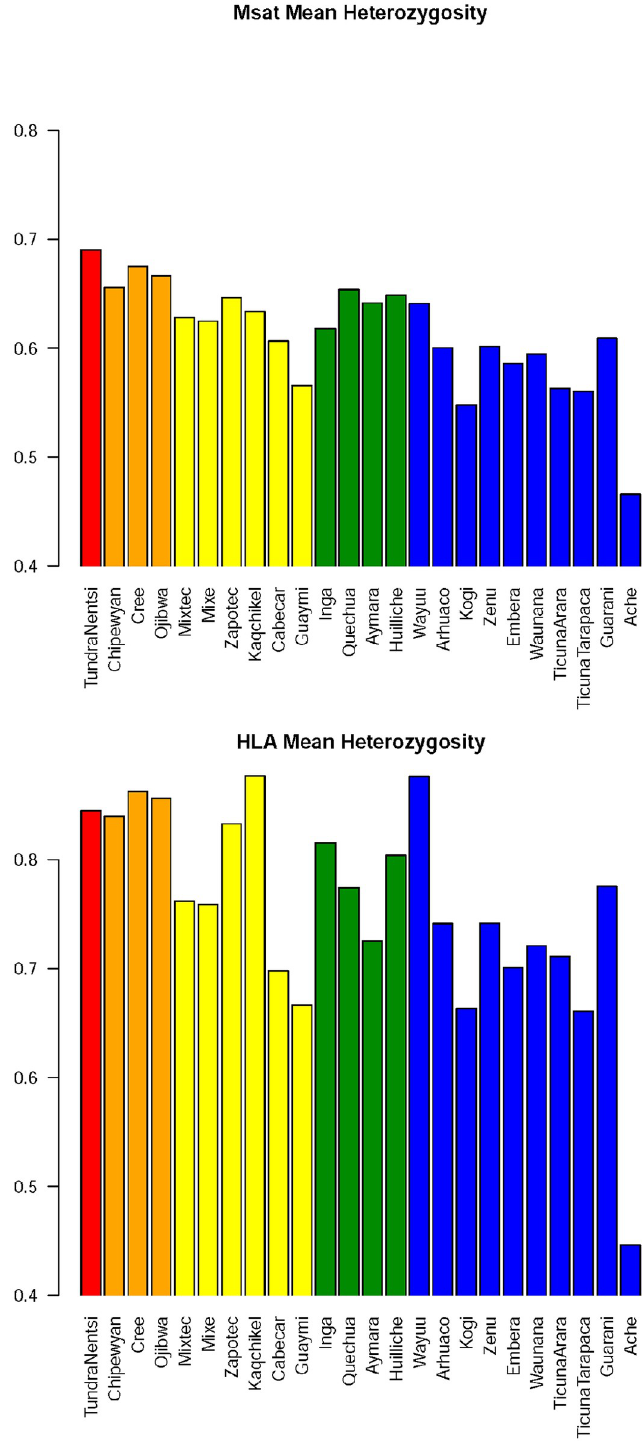
Fig 2. (a, b) Heterozygosity values per population and geographic region (a) Microsatellites, (b) HLA. Populations are ordered within geographic regions based on the least cost path (Wang et al, 2007), which indicates the distance from Siberia along likely migration